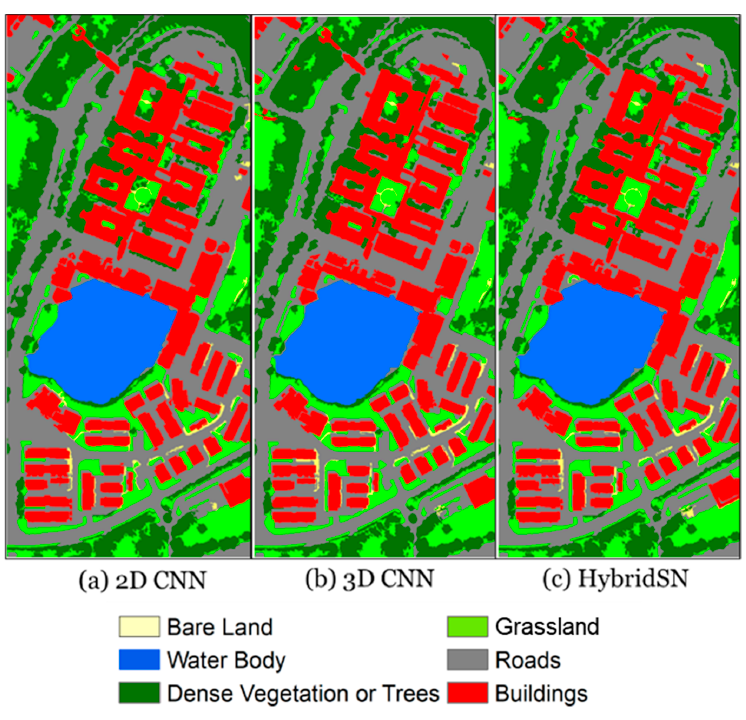
Figure 7. Classification maps of different CNN methods for the test area. Table 4. Classification assessment of different CNN methods used with the proposed model for the training and test areas.